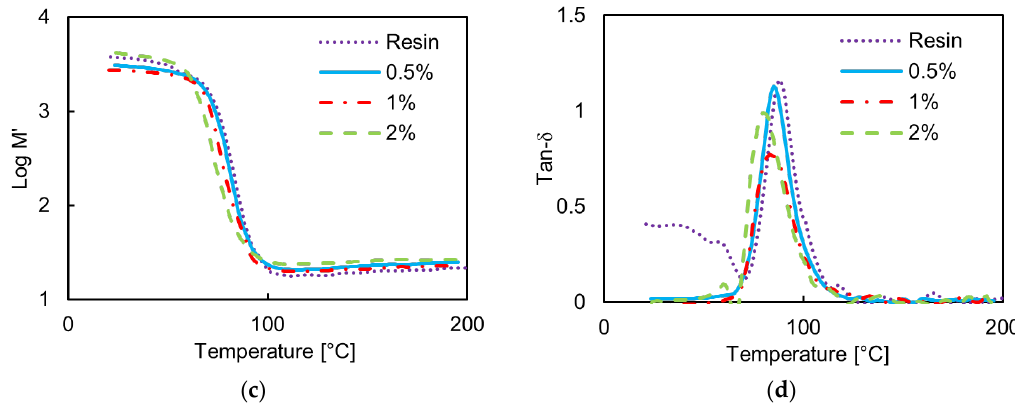
Figure 5. Measured storage modulus M ’ and loss tangent tanδ vs. temperature of the neat epoxy resin and of the epoxy-based composites filled with GNPs at increasing wt. % concentration: ( a ) M ’ and ( b ) tanδ at 5 Hz; ( c ) M ’ and ( d ) tanδ at 30 Hz.